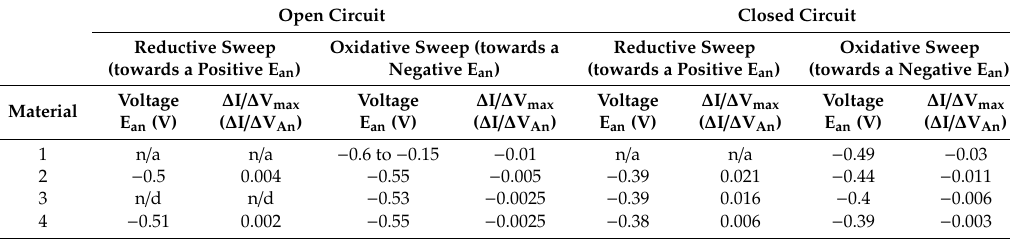
Table 3. First derivative potentials and amplitudes for closed- and open-circuit oxidative and reductive sweeps. E (V) versus Ag / AgCl. Open Circuit Closed